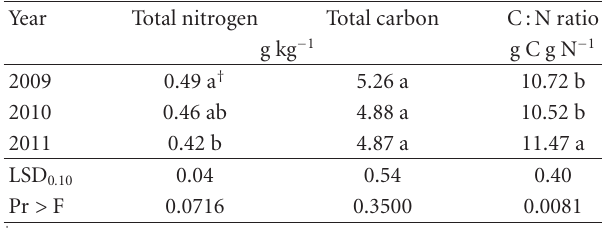
Table 1: Soil total nitrogen, carbon, and C:N ratio for a sandy loam soil in the Mid-Atlantic by